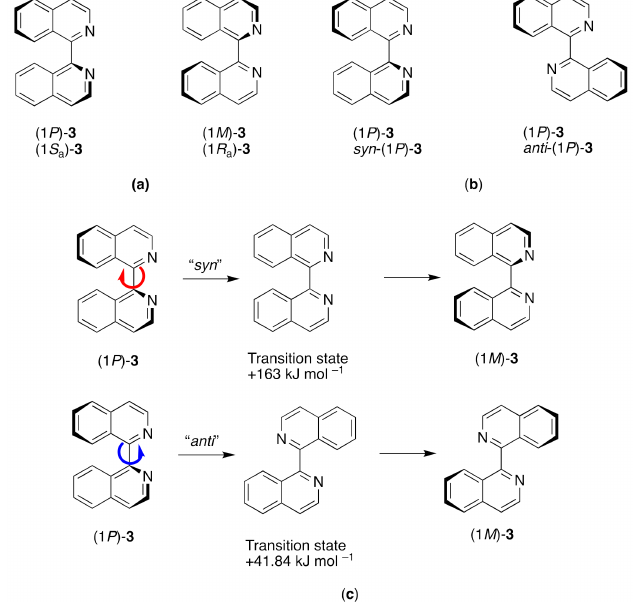
Figure 4. ( a ) The two enantiomeric (atropisomeric) forms of 1,1 (cid:48) -biisoquinoline; ( b ) each enantiomer can adopt a syn or an anti conformation ( syn N–C–C–N torsion angle < 90 ◦ , anti N–C–C–N torsion angle > 90 ◦ ); ( c ) racemization can involve a rotation through a syn (the red arrow denotes the direction of rotation of the top quinoline) or an anti (the blue arrow denotes the direction of rotation of the top quinoline) conformation. The latter is favored as the H8 and H8 (cid:48) atoms do not have to pass through each